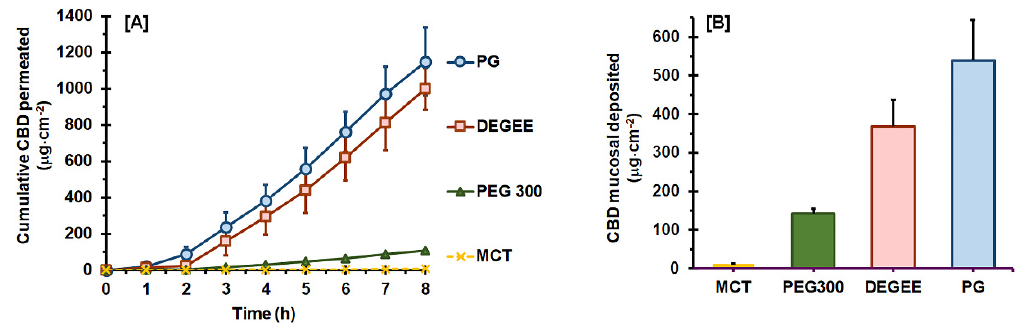
Figure 1. Ex vivo permeation profiles of CBD through porcine mucosa from various neat vehicles ( A ) and the mucosal deposition amount of CBD after permeation ( B ) (mean ± SD, n = 4). Table 2. Vehicle uptake capacity of mucosa and ex vivo permeation parameters of CBD with neat